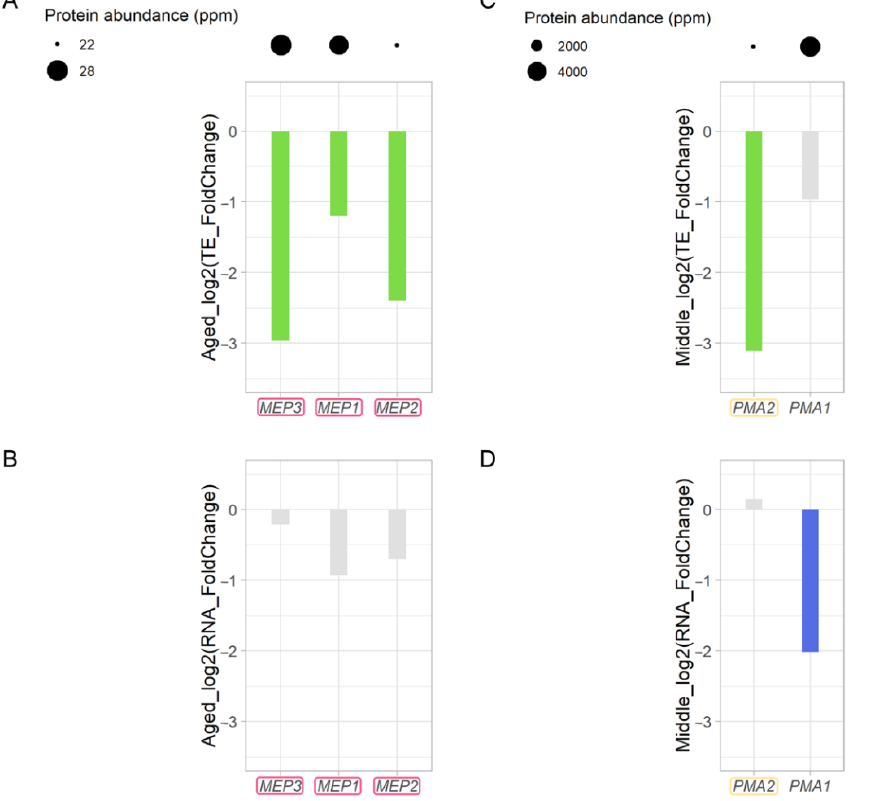
Figure 8. Translation of genes encoding ammonium permease and plasma membrane H + -ATPase decreases in Aged cells. Changes in translational efficiency ( A ) and RNA ( B ) of MEP3 , MEP1 , and MEP2 genes (indicated by the red box) and changes in translational efficiency ( C ) and RNA ( D ) of PMA2 (indicated by the yellow box) and PMA1 genes are shown. Green indicates downregulation of translational efficiency by more than twofold. Blue indicates downregulation of RNA by more than twofold. Grey indicates no notable changes. Young cells were used as a control.